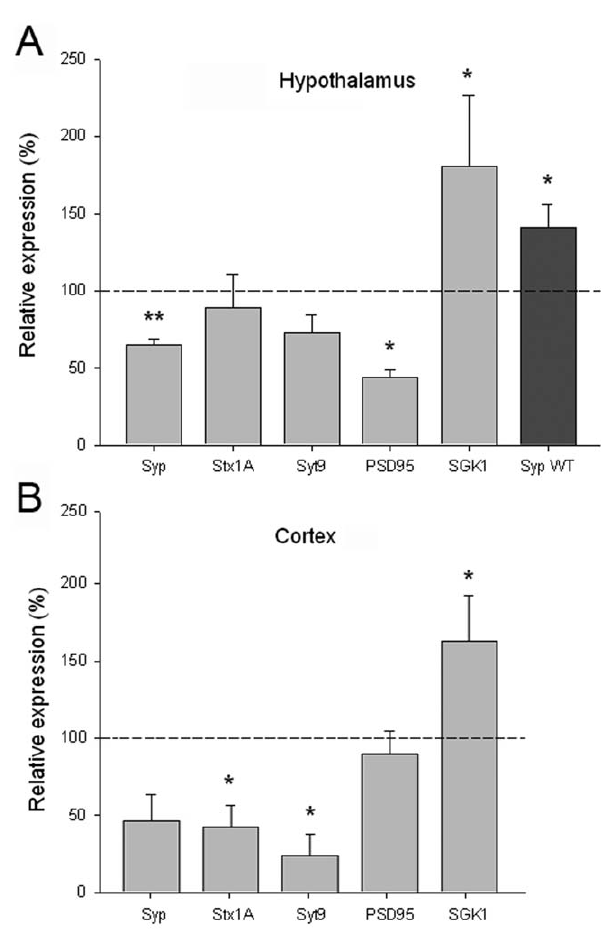
Figure 4. Environmental Enrichment on Mecp2 2 /y -EE mice induces a decrease in the expression of a set of synaptic plasticity-related genes. A, A significant difference in the steady- state level of mRNA for Syp, PSD95 and SGK-1 was observed in hypothalamus of Mecp2 2 /y -EE in comparison with in Mecp2 2 /y -SC mice assessed by qRT-PCR. Syp WT: The expected EE-induced increase in Syp in Mecp2 + /y -EE (normalized to Mecp2 + /y -SC) is shown as a darker bar. B, In samples from cerebral cortex, differences were detected in Syt9, Stx1a and SGK-1. The results are expressed as percentage of the Mecp2 2 /y -SC control group. * p , 0.05 by Student’s test (n=5 for each group).